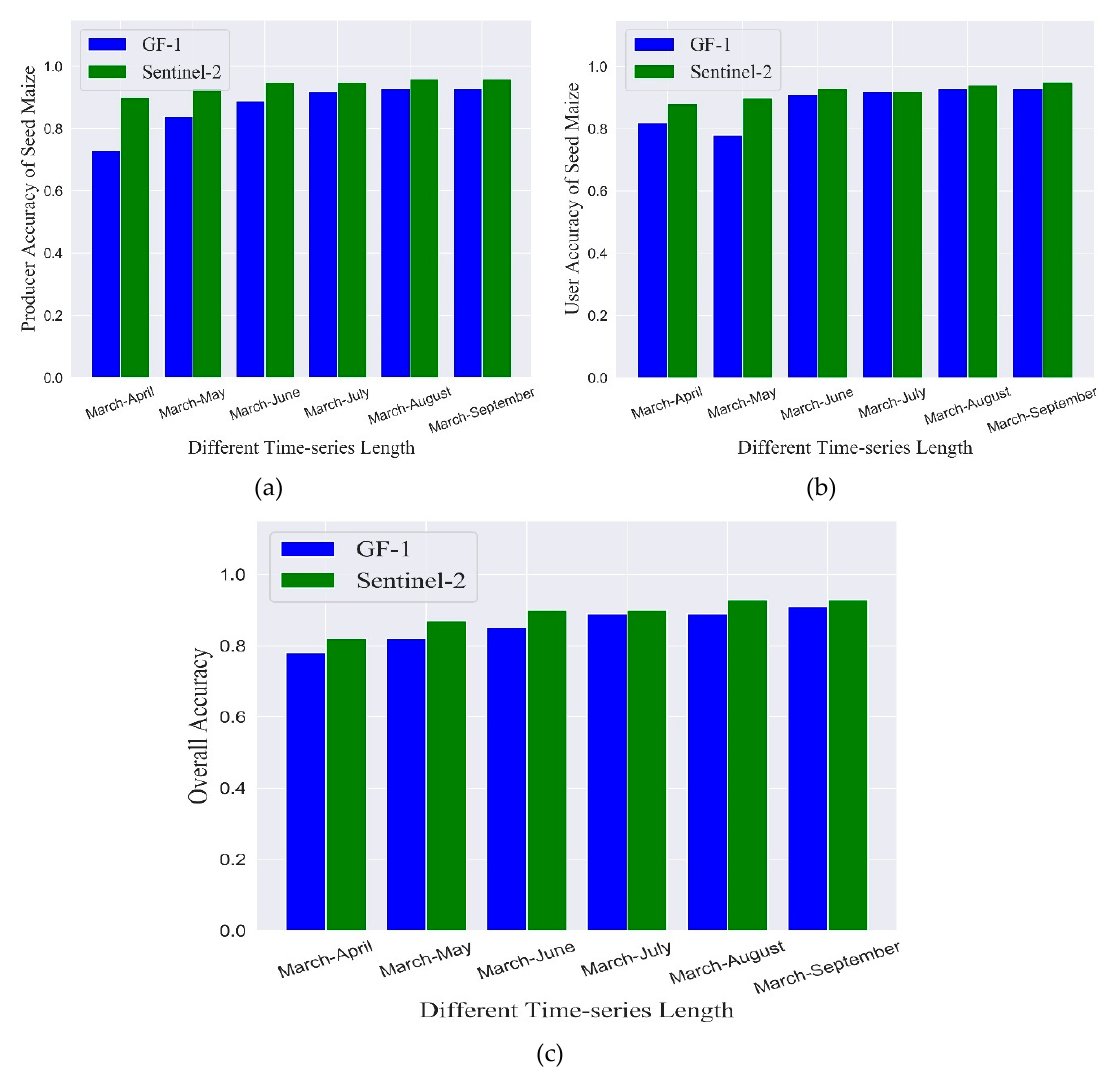
Figure 11. The comparison of accuracy based on Sentinel-2 and GF-1. ( a ) PA of seed maize. ( b ) UA of seed maize. ( c ) OA.